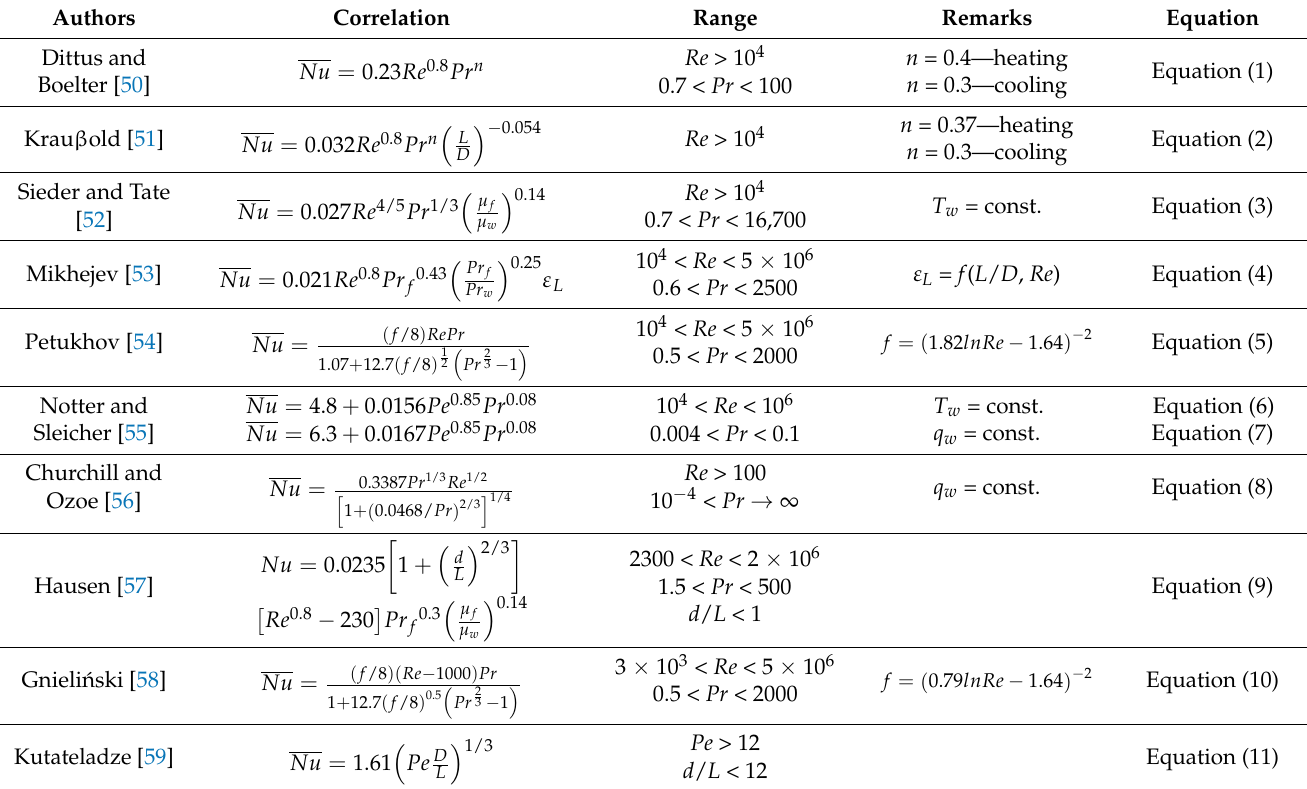
Table 2. Correlation equations for turbulent flow of base